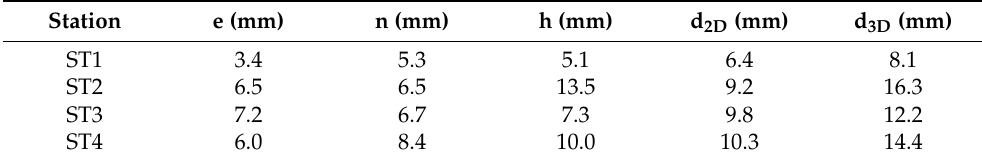
h), and spatial absolute (d 3D ) positions from the true position (Figure 11). Table 8. RTK positioning precision in the open-sky (ST 1) and urban areas (ST 2, ST 3, and ST 4). Station